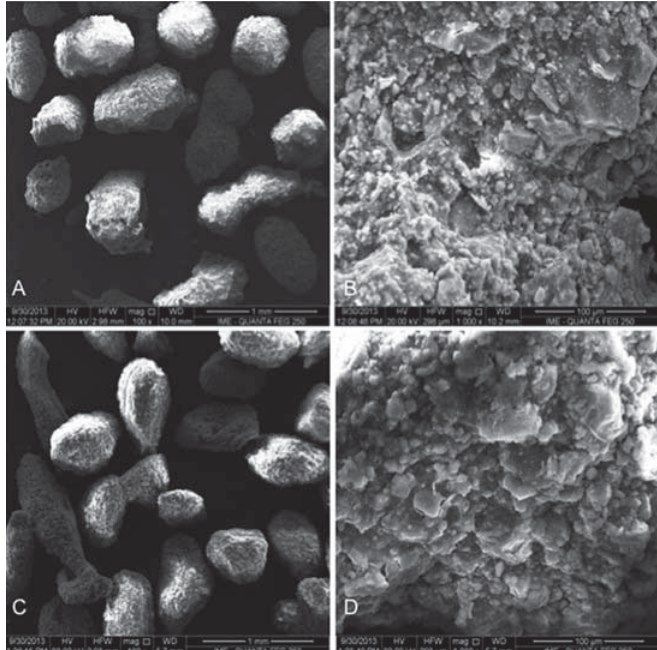
Figure 2- Scanning Electron Microscopy (SEM) micrographs. A: Carbonated hydroxyapatite (CHA) spheres; B: CHA spheres surface, both without thermal treatment; C: Hydroxyapatite (HA) spheres, and D: HA spheres surface. A and C: